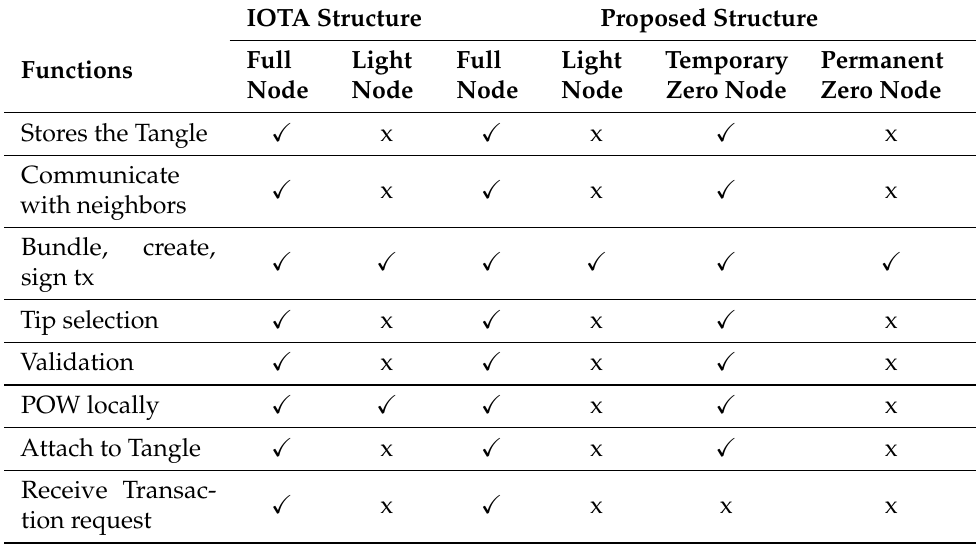
Table 1. IOTA node